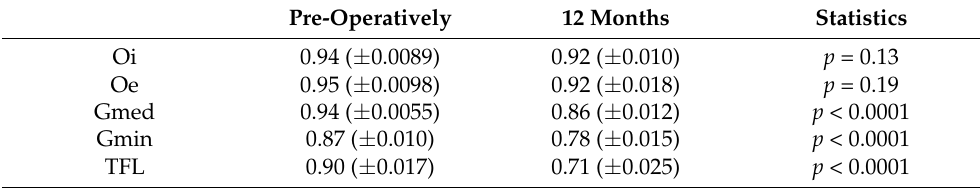
Table 1. A/N ratio of muscle cross-sectional area pre-operatively, 12 months post-operatively. Pre-Operatively